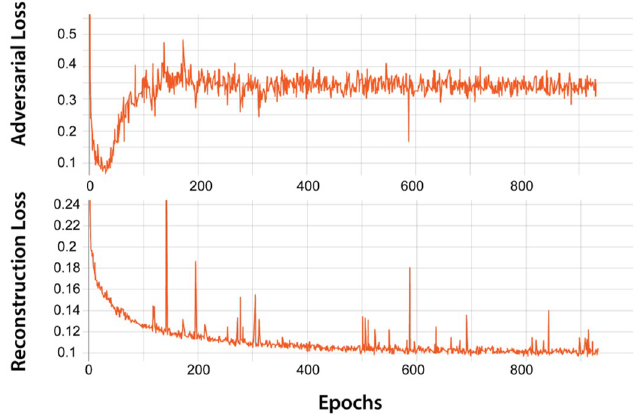
Fig 2. Computational model performance. (A) Adversarial and Reconstruction loss over training